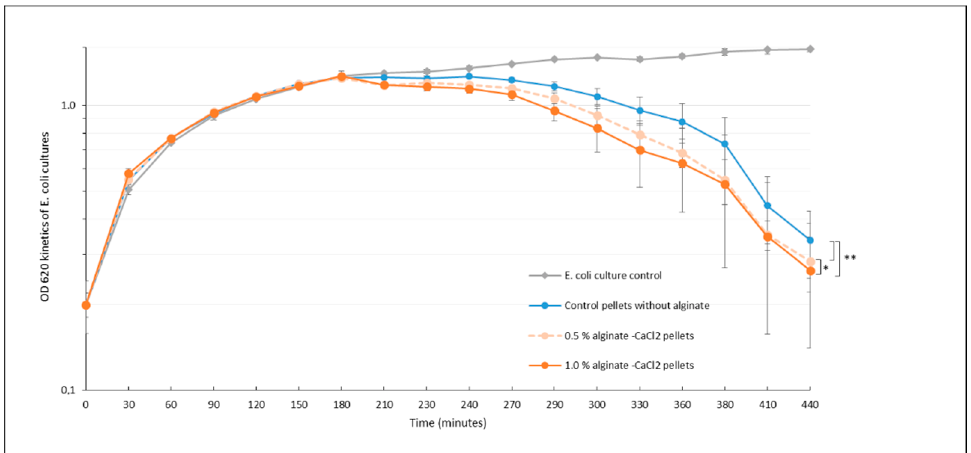
Figure 2. Lytic kinetics of bacterial cultures in the presence of phage-loaded β -TCP pellets coated with different alginate concentrations after 3 h of washing in LB (37 °C, 170 rpm) ( n = 3 × 2). *, Significantly- similar groups of results and **, significantly-different groups of results with p -value <0.05. The grey kinetic corresponds to the results for the control culture of E.coli .